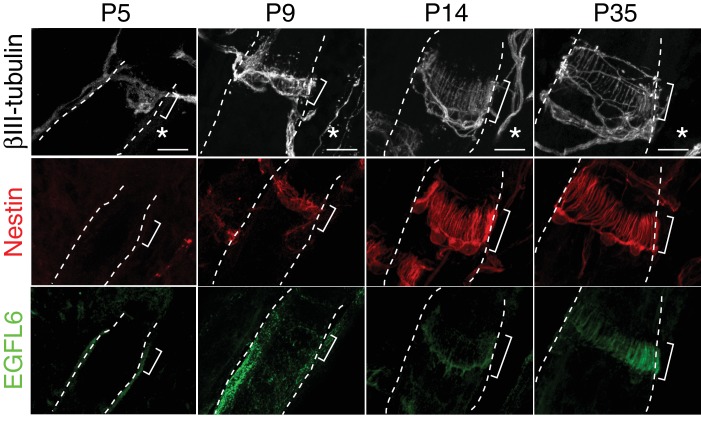
EGFL6 localization and lanceolate complex formation during hair follicle development.Maximum projection images of P5, P9, P14 and P35 mouse dorsal hair follicles stained for βIII-tubulin, nestin and EGFL6. Brackets indicate upper-bulge regions. Asterisks indicate the caudal sides of dorsal skin. Scale bars, 10 μm.